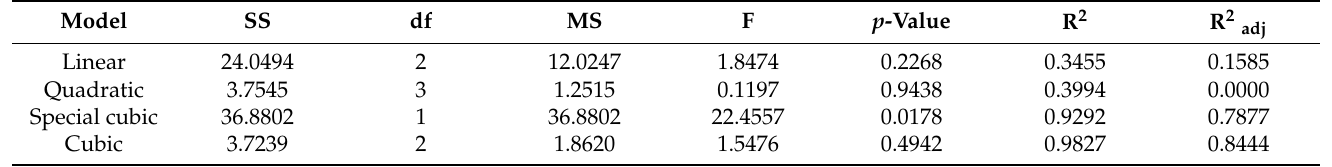
Table 5. ANOVA results for different statistical models for R. mucilaginosa